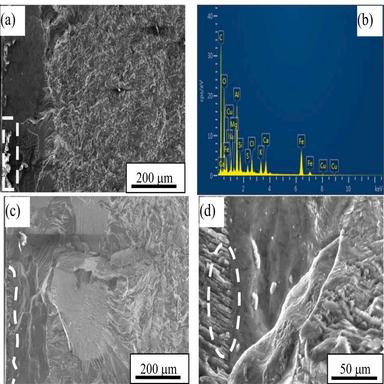
Analysis of fractures; brightly white matters in (a) and EDS result in (b) for a stress level of 120 MPa; discrete bar-like features in (c) and the magnifying result in (d) for a stress level of 160 MPa;